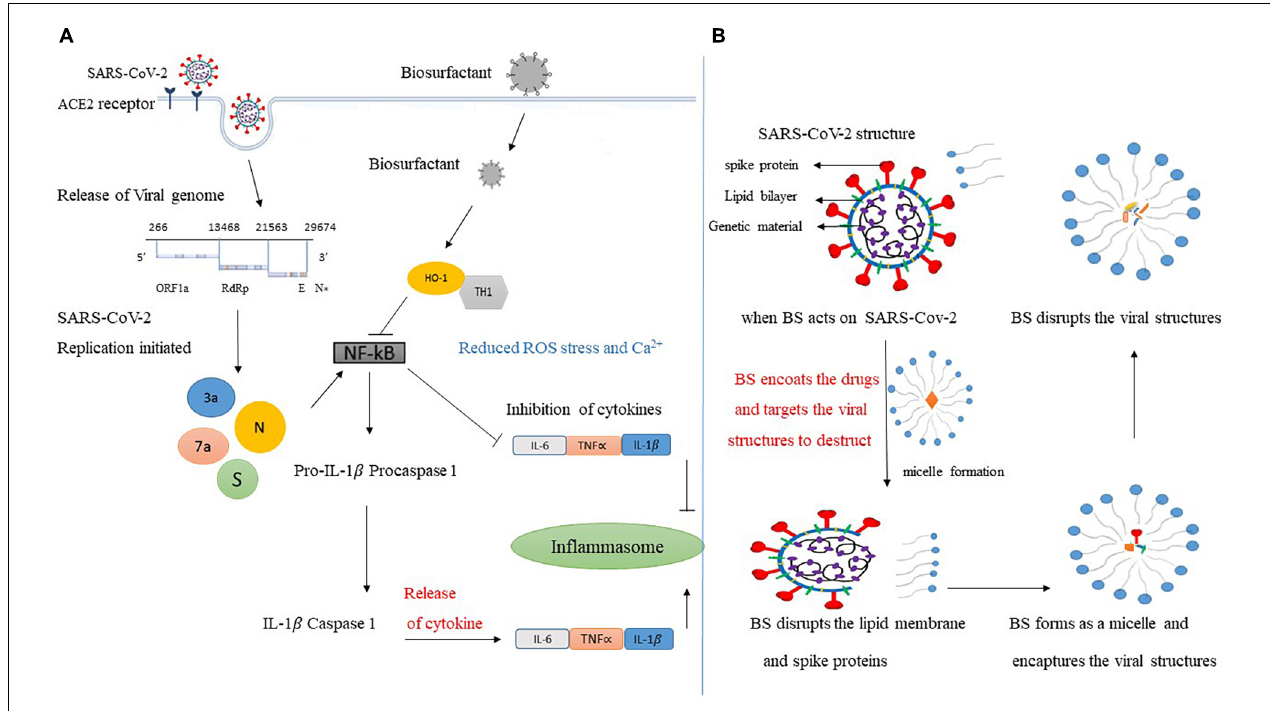
FIGURE 1 | (A) B. subtilis has an essential role against COVID-19-associated inflammation. (A) Shows that the BS produced by B. subtilis due to its anti-inflammatory property can be a perfect candidate against COVID-19. When the virus enters the host cell, with the help of TMPRSS2 by cleaving the S protein to S! and 2 subunits, it will bind to ACE2 receptor. Consequently, the replication of virus initiated to NF- κ B pathway will stimulate the cytokine storm release. At this phase, offering COVID-19 patients surfactin in addition to other medications promises to inhibit the NF- κ B production by affecting the TH1 and HO-1 macrophages, which will decrease the cytokine storm impacts and COVID-19-associated inflammation. (B) Antiviral mechanism of BS against SARS-CoV-2 virus; BS shall work on the structure of the virus such as lipid envelope and spike protein, and also can rapture the outer membrane and inactivate the virus by targetting the genetic material. Disruption of viral structure will result in the formation of micelle and engulfment of vital parts and turn it into an inactive form.